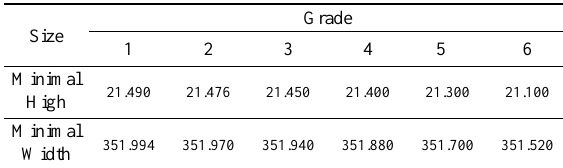
Table 5. the minimum section size of interior rail in axis